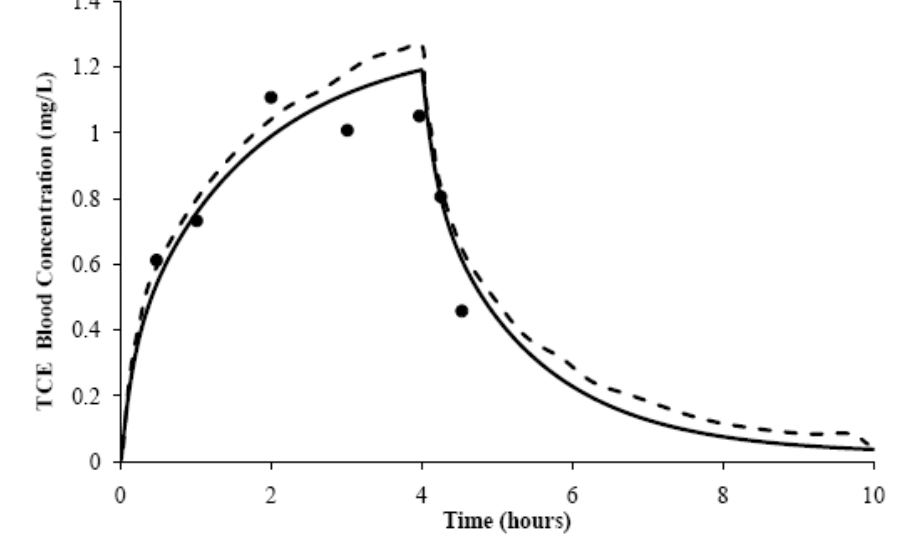
Figure 1. Trichloroethylene (TCE) blood concentrations ( ● ) measured over time, simulation (---) and our generic VOCs model simulation (—) are also shown.